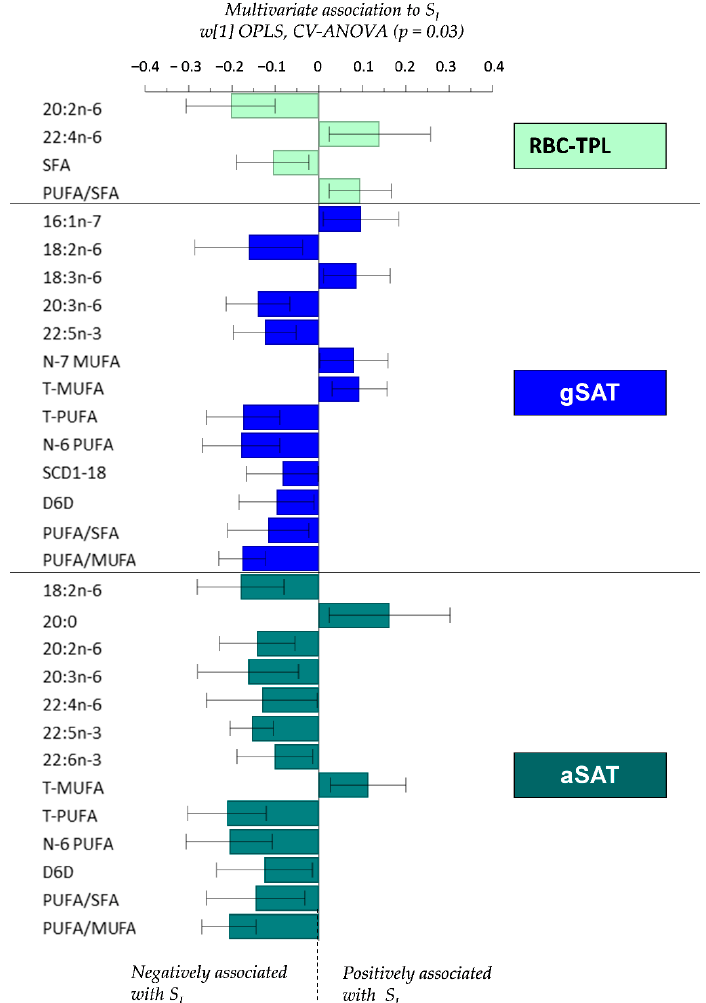
Figure 2. Multivariate OPLS associations between tissue-specific fatty acid composition and S I . Only the individual and grouped FA and FA ratios in each tissue type that were significantly (95% confidence level) associated with S I are presented in the figure. All fatty acids shown in Table 3 were included